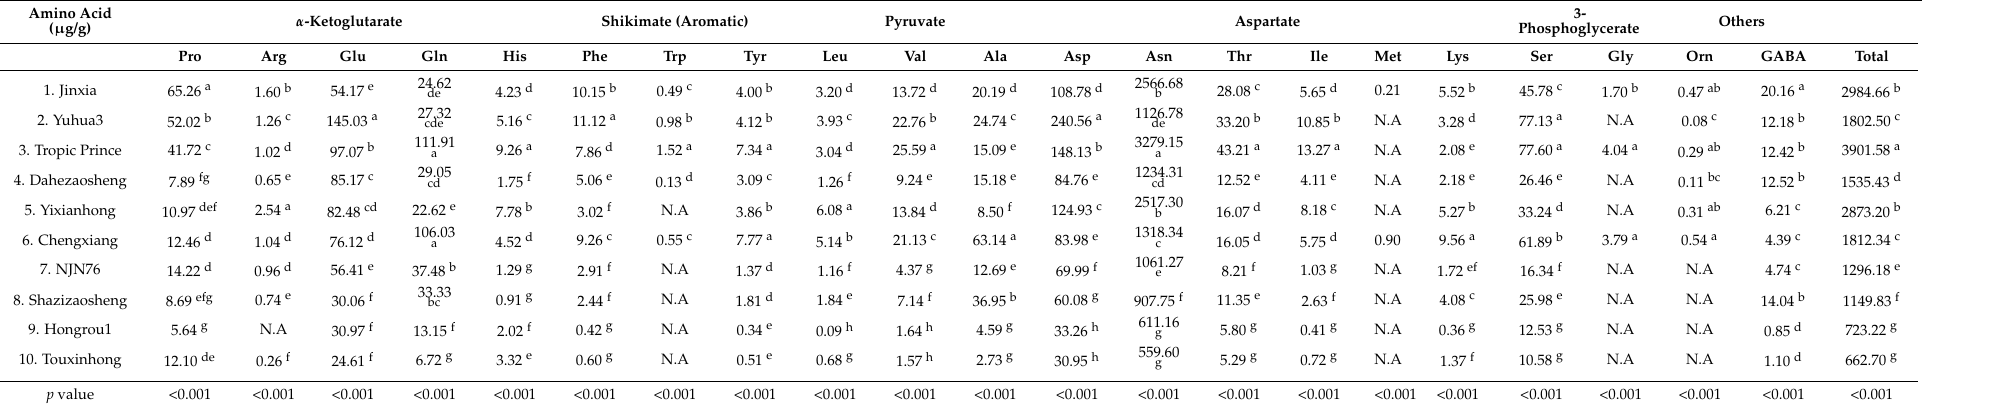
Table 3. Amino acids of 10 peach and nectarine varieties at harvest ( µ